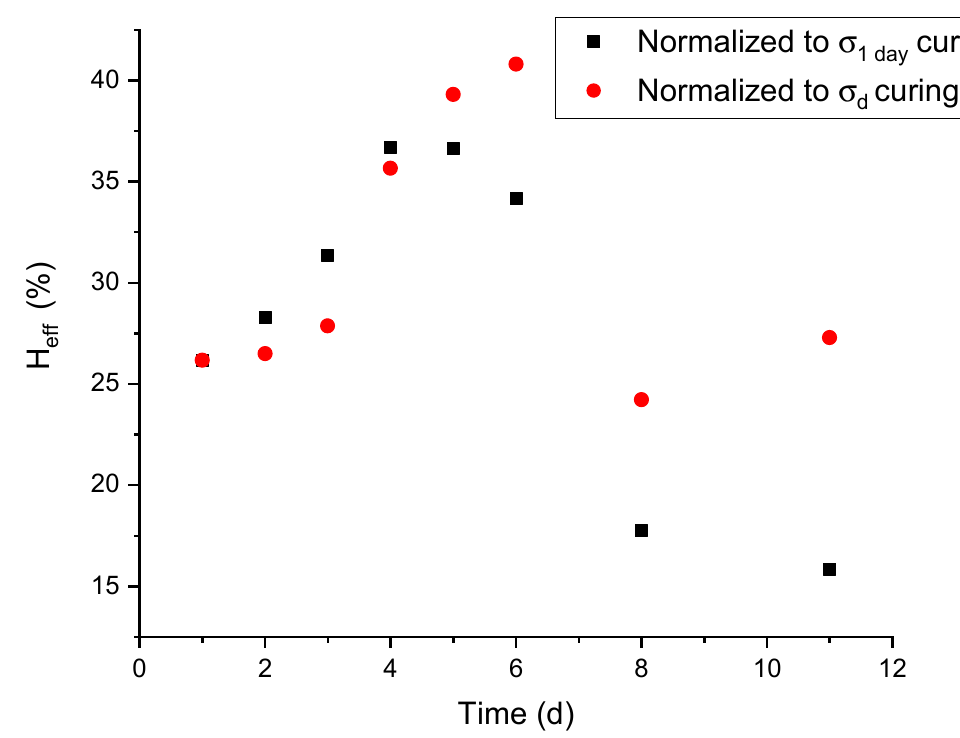
Figure 5. Time-dependency of the healing efficiency. All measurements were performed at 100 °C (the average standard deviation is SD σ 1 day = 10.31% and SD σ d = 9.63%).